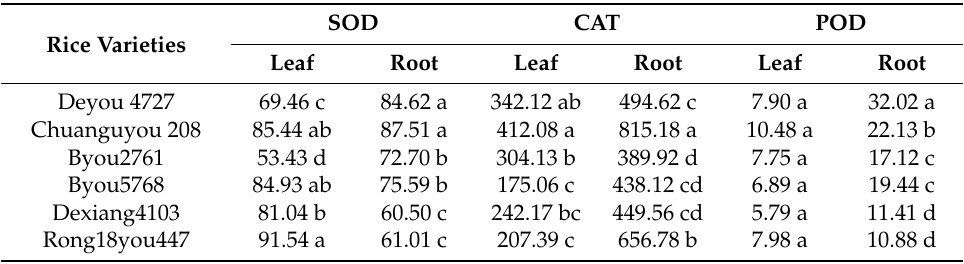
Table 3. Effect of drought stress on antioxidant enzyme activity in rice varieties. SOD, Superoxide dismutase; CAT, Catalase; POD, Peroxidase. SOD CAT POD Rice Varieties Leaf Root Leaf Root Leaf Root Deyou 4727